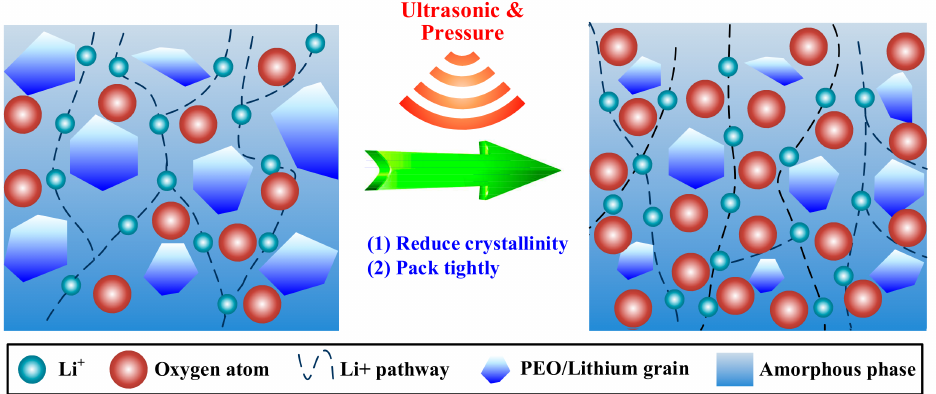
Figure 16. Ultrasonic promotion of ionic conductivity of the solid polymer electrolyte